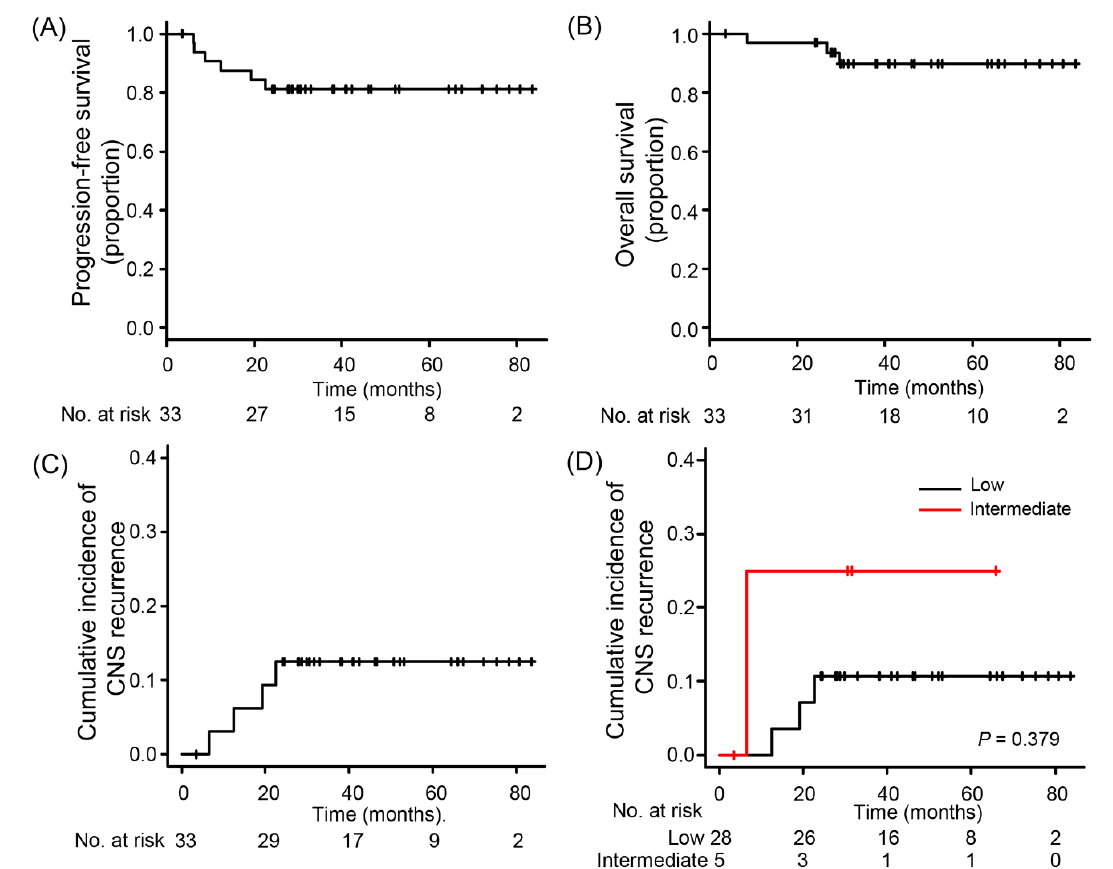
Figure 2. ( A ) Progression-free survival, ( B ) overall survival, ( C ) cumulative incidence of CNS relapse, and ( D ) cumulative incidence of CNS relapse according to CNS-IPI. Abbreviations: CNS, central nervous system; CNS-IPI, central nervous system-International Prognostic Index.